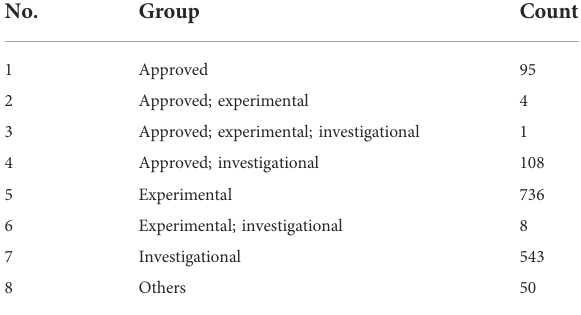
TABLE 1 Groups of 1,545 compounds in DrugBank. No.